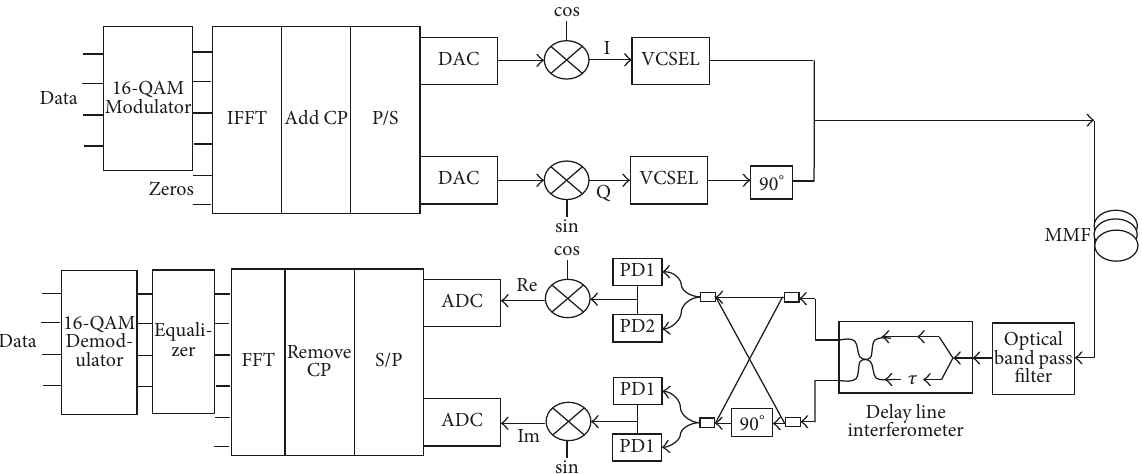
Figure 1: Schematic diagram of the DDO-OFDM system with an optical I/Q modulator using VCSELs for MMF links.